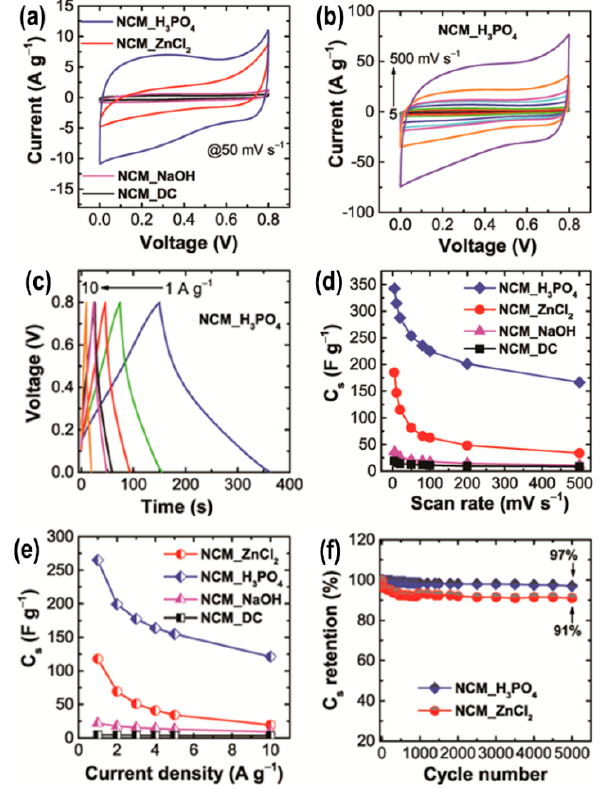
Figure 7. Electrochemical performance (cyclic voltammetry and chronopotentiometry) of activated nanoporous carbon materials (NCM) derived from chemical activation of Areca Catechu Nut ( a ) Comparison of CV curves for the prepared samples at 50 mV s − 1 , ( b ) CV curve vs. scan rate for NCM_H 3 PO 4 characteristic of EDLC behavior, ( c ) Corresponding CD curve vs. current densities (1 − 10 A g − 1 ), ( d ) Calculated specific capacitances vs. scan rates for prepared